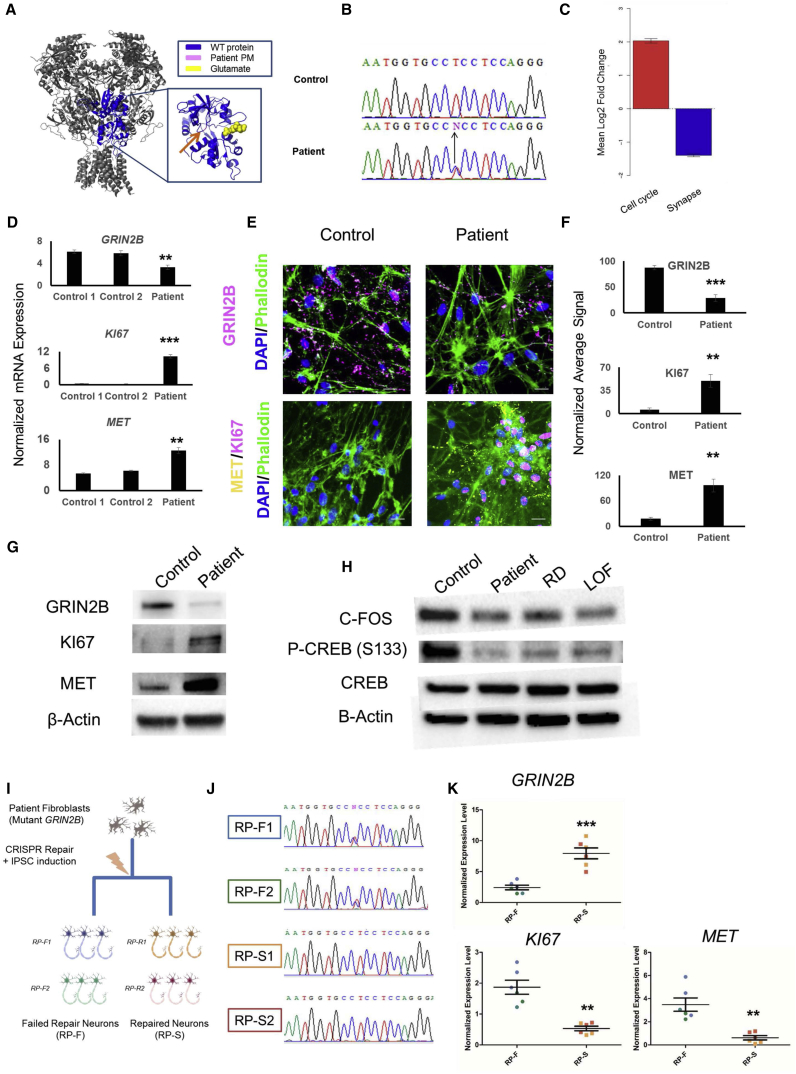
Forebrain Neurons Derived from a GRIN2B Mutation Patient Have Impaired Differentiation that Is Reversible by Genetic Repair(A) Structure of the NMDA receptor, with a magnified view of the glutamate binding site. The patient mutation E413G is displayed in pink and is highlighted with an orange arrow.(B) Sanger sequencing of the patient and a healthy control at the site of mutation in GRIN2B.(C) Average fold change of genes differentially expressed in iPSC-derived neurons from patient E413G compared with controls belonging to the Cell Cycle or Synapse GEO terms.(D) qPCR validation of GRIN2B, KI67, and MET mRNA upregulation in D30 neurons derived from the patient compared with control. Data normalized to GAPDH expression. Error bars denote SEM; n = 3 independent experiments, with each data point obtained from a separate culture of neuronal cells: ∗∗p < 0.01; ∗∗∗p < 0.001.(E) Representative ICC images of GRIN2B, KI67, and MET immunopositive neurons for patient and control D30 neurons. Scale bars represent 25 μm.(F) Quantification of GRIN2B, MET, and KI67 immunopositive signals in neurons from patient D30 neurons compared with control. Error bars denote SEM; n = 7 independent experiments, with each data point representing quantifications of coverslips obtained from separate cultures of each cell line. ∗∗p < 0.01; ∗∗∗p < 0.001.(G) Western blot of GRIN2B, KI67, MET, and β-actin using lysates obtained from control and patient D30 forebrain neurons.(H) Western blot of C-FOS, P-CREB, CREB, and β-actin using lysates obtained from control and patient, RD, and LOF D30 forebrain neurons.(I) Diagram of the experimental procedure used to generate failed repair (RP-F) and successful repair (RP-S) neurons from patient fibroblasts.(J) Sanger sequencing of two failed and successful repaired lines at the site of mutation shown in (B).(K) Normalized expression level of GRIN2B, MET, and KI67 mRNA in failed and successful repair D30 neurons. Measurements are matched by color to the specific line to which they correspond (blue: RP-F1; green: RP-F2; orange: RP-S1; red: RP-S2). Error bars denote SEM; n = 6 independent experiments, with each data point obtained from a separate culture of neuronal cells. ∗∗p < 0.01; ∗∗∗p < 0.001.See also Figure S5.